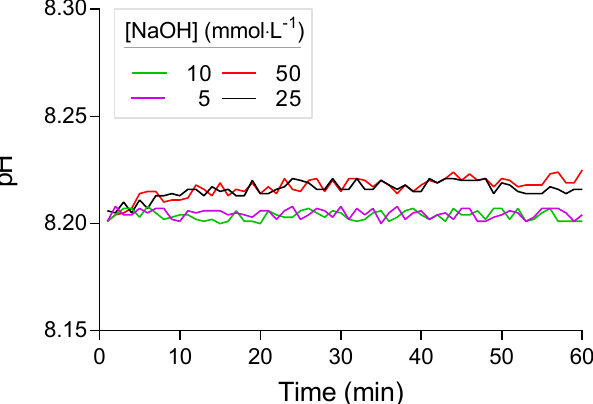
Figure 3. pH drift in substrate (PLA) suspension (3 mg · mL − 1 ) in artificial seawater over time with different concentrations of NaOH titrant. Endpoint of the titration was set to 8.2. Titrant was added at NaOH concentrations of 5 and 10 mmol · L − 1 (dashed lines) to counterbalance the pH drop (see main text).